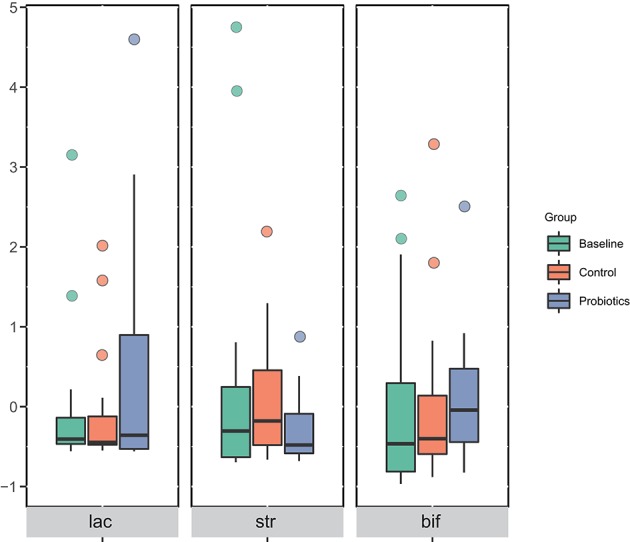
The corresponding bacteria of ingested probiotics varied in each group at the genus level. The data were processed for standardization using the Z-score method, and the y-axis represents the rate of change in relative abundance. lac, Lactobacillus; str, Streptococcus thermophilus; bif, Bifidobacterium.